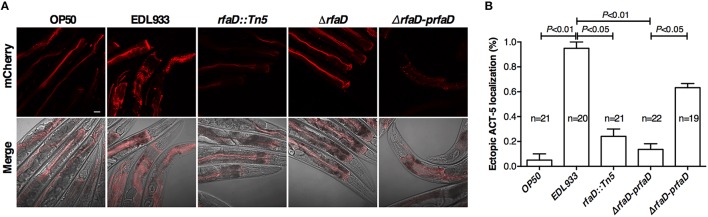
Mutations in rfaD reduce EHEC-induced intestinal microvillar actin rearrangement in C. elegans. (A) The confocal images showed the mCherry-tagged ACT-5 (intestinal microvillar actin) of GK454 transgenic animals fed with OP50, EDL933, EDL933 rfaD::Tn5 (rfaD::Tn5), EDL933:ΔrfaD (ΔrfaD) or EDL933:ΔrfaD-prfaD (ΔrfaD-prfaD) for 4 days respectively. Ectopic localization of the mCherry::ACT-5 signals from the apical membrane to the cytoplasm of the intestinal cells were significantly increased in the EDL933 treated group. Upper panels show mCherry images; lower panels are the merge images of the DIC and mCherry signals. Representative images are shown, and scale bar represents 10 μm. (B) Quantifications of animals with the EHEC-induced ectopic mCherry::ACT-5 signal were determined. Values represent the means of three independent assays, and error bars indicate the standard deviations. P-values denote the results of statistical analysis.